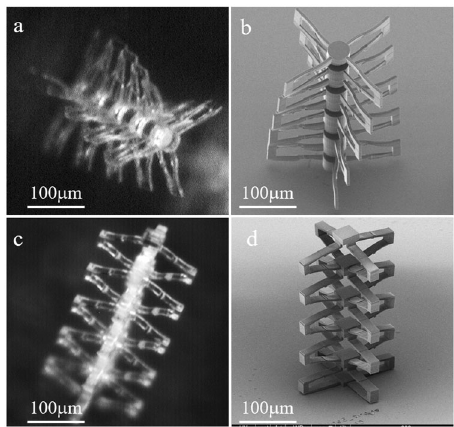
Fig. 3 Functional stacks fabricated by gray-tone lithography. a , c Optical micrographs and b , d SEM images. Each stack is composed of fi ve elements. The samples are composed of two constituent components fabricated with a single photoresist but two different laser exposure powers. Differential shrinkage during development leads to pre-bending of the bilayer beams, further leading to rotation (translation) of the stack shown in the